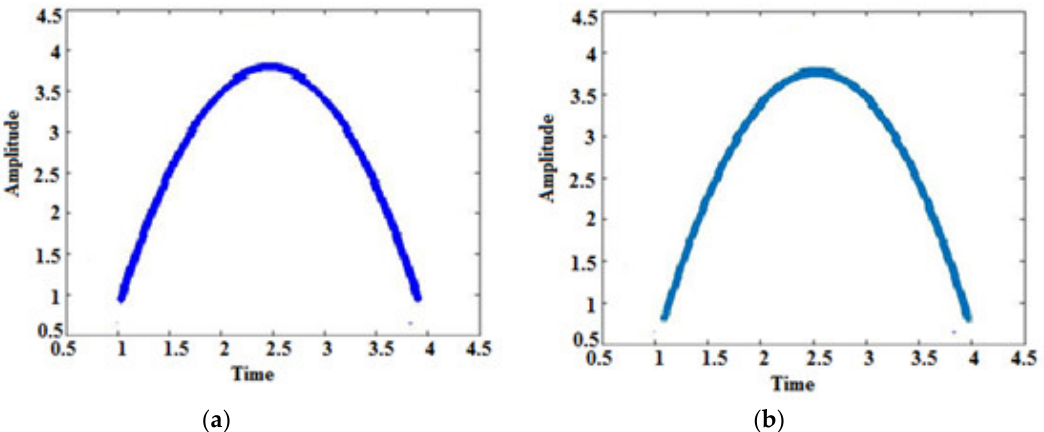
Figure 7. Signal after removing Noise from Figure 6. ( a ) Proposed method; ( b ) existing method (FsLMS).